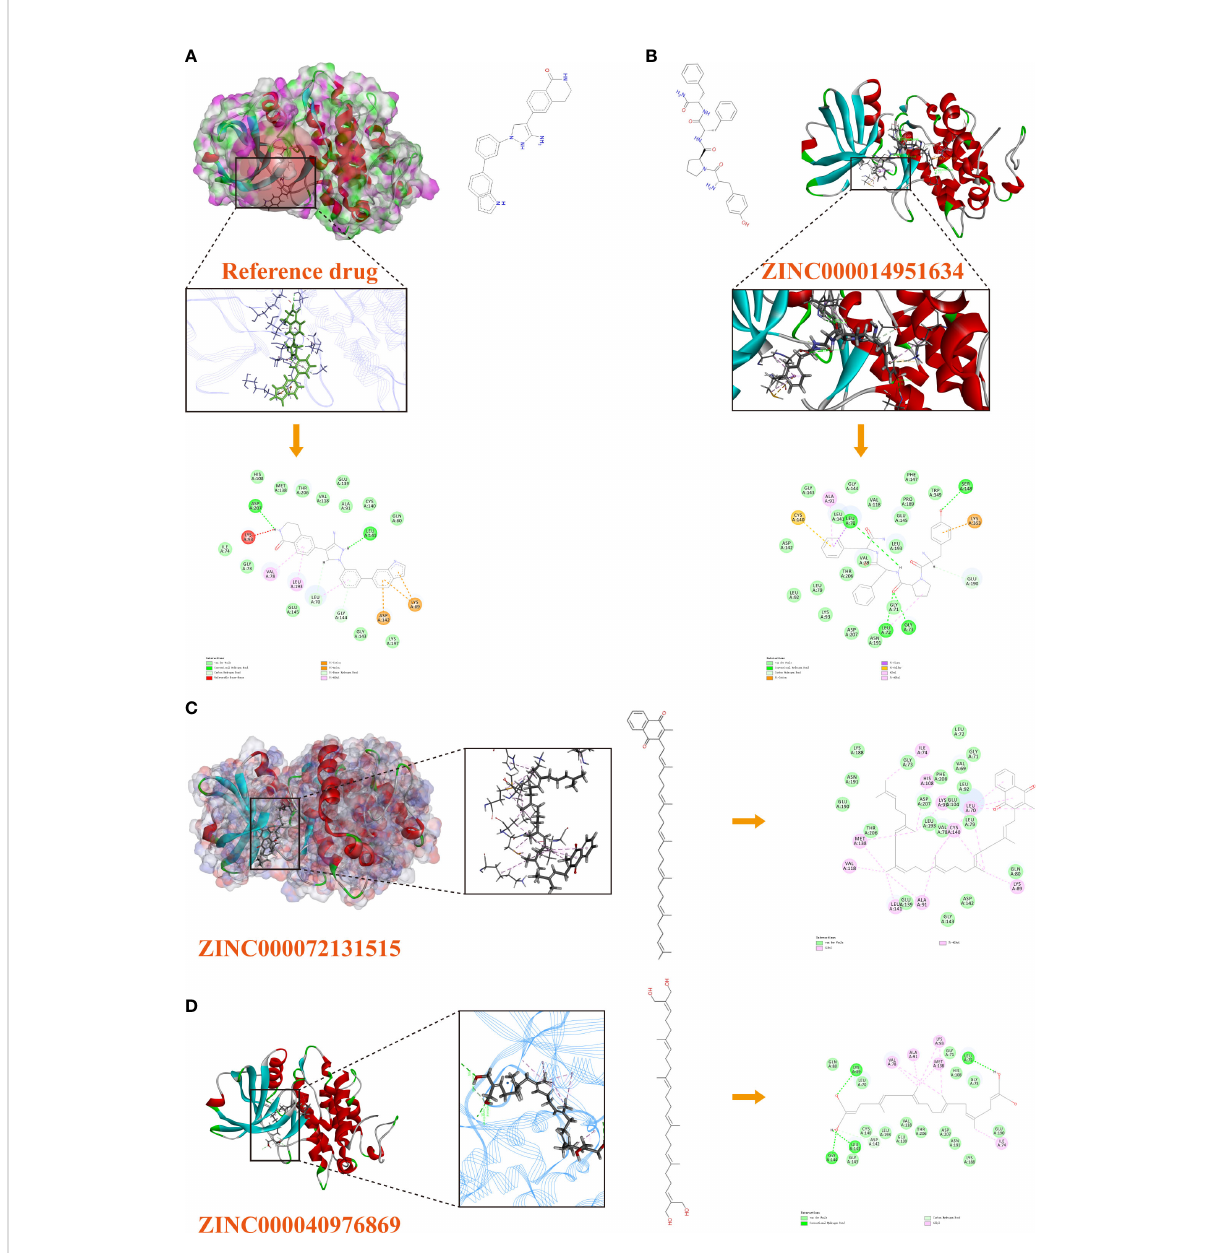
FIGURE 5 (A) The docking pattern illustrating the chemical bond interactions of the reference drug and MAPKAPK2. (B) The docking pattern illustrating the chemical bond interactions of ZINC000014951634 and MAPKAPK2. (C) The docking pattern illustrating the chemical bond interactions of ZINC000072131515 and MAPKAPK2. (D) The docking pattern illustrating the chemical bond interactions of ZINC000040976869 and